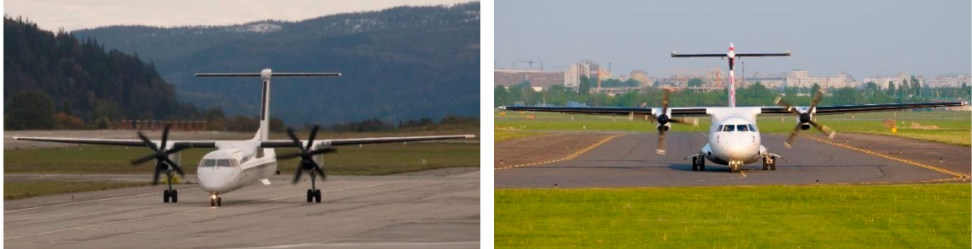
Figure 4. Landing gear installation solution for a large propeller driven